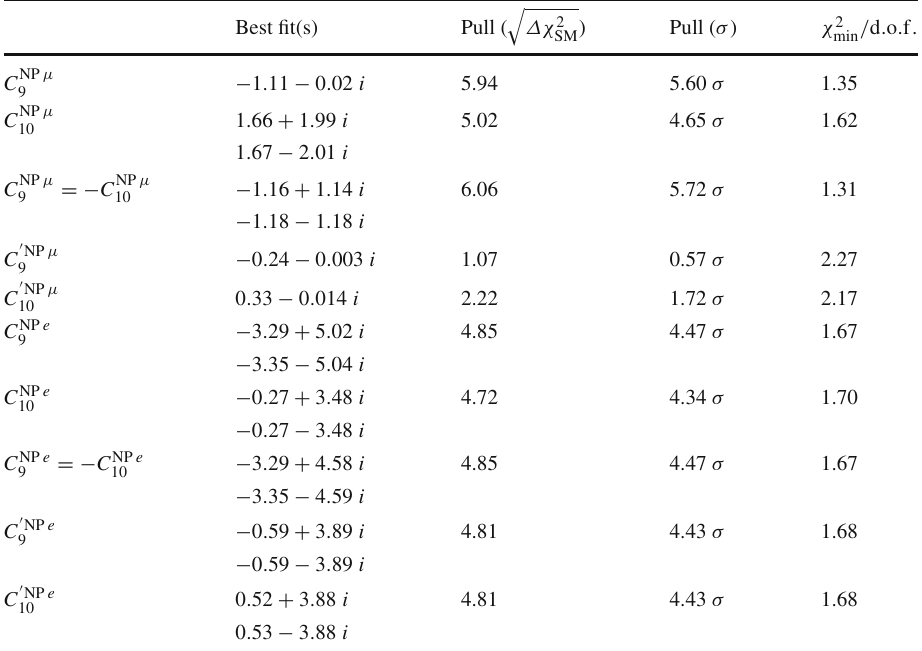
coefficients complex values to semi-leptonic decay observables R K , R K ∗ 0 , P (cid:2) and P (cid:2) , allowing 4 5 only one free coefficient at a